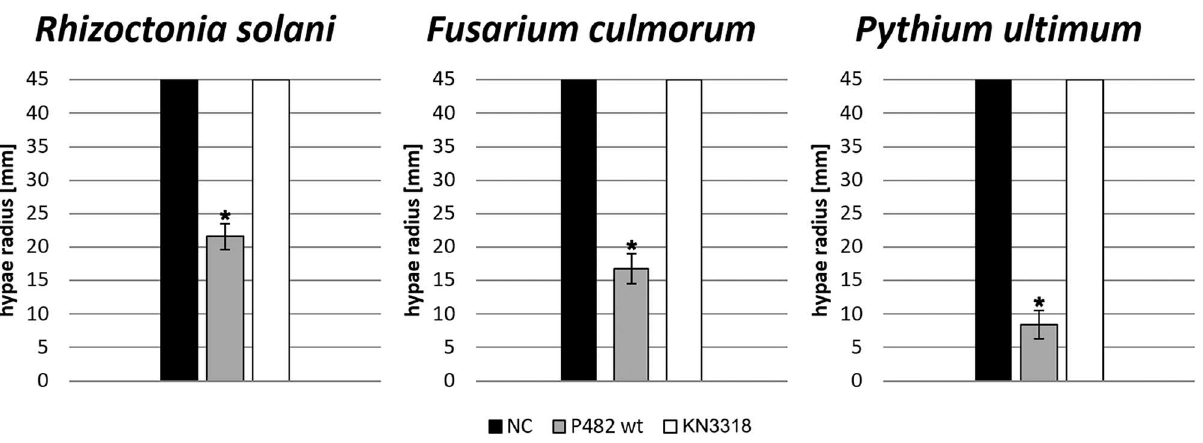
Fig 1. Averagehyphae radius after 4 days ( Rhizoctonia solani ), 7 days ( Fusarium cilmorum ) and 5 days ( Pythium ultimum ) of incubation under influence of volatiles emitted by P . donghuensis P482 wt, KN3318 mutant and non-treated control (NC). Significantdifference betweensample and control are indicatedby asterisk (one-wayANOVA), error bars represents standarddeviationof the mean.